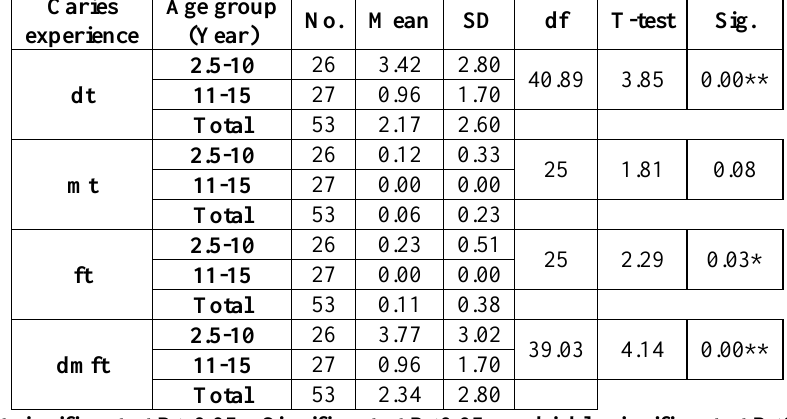
Table 1: Caries experience of primary dentition (mean and standard deviation) among patient with Juvenile Idiopathic Arthritis according to age Caries